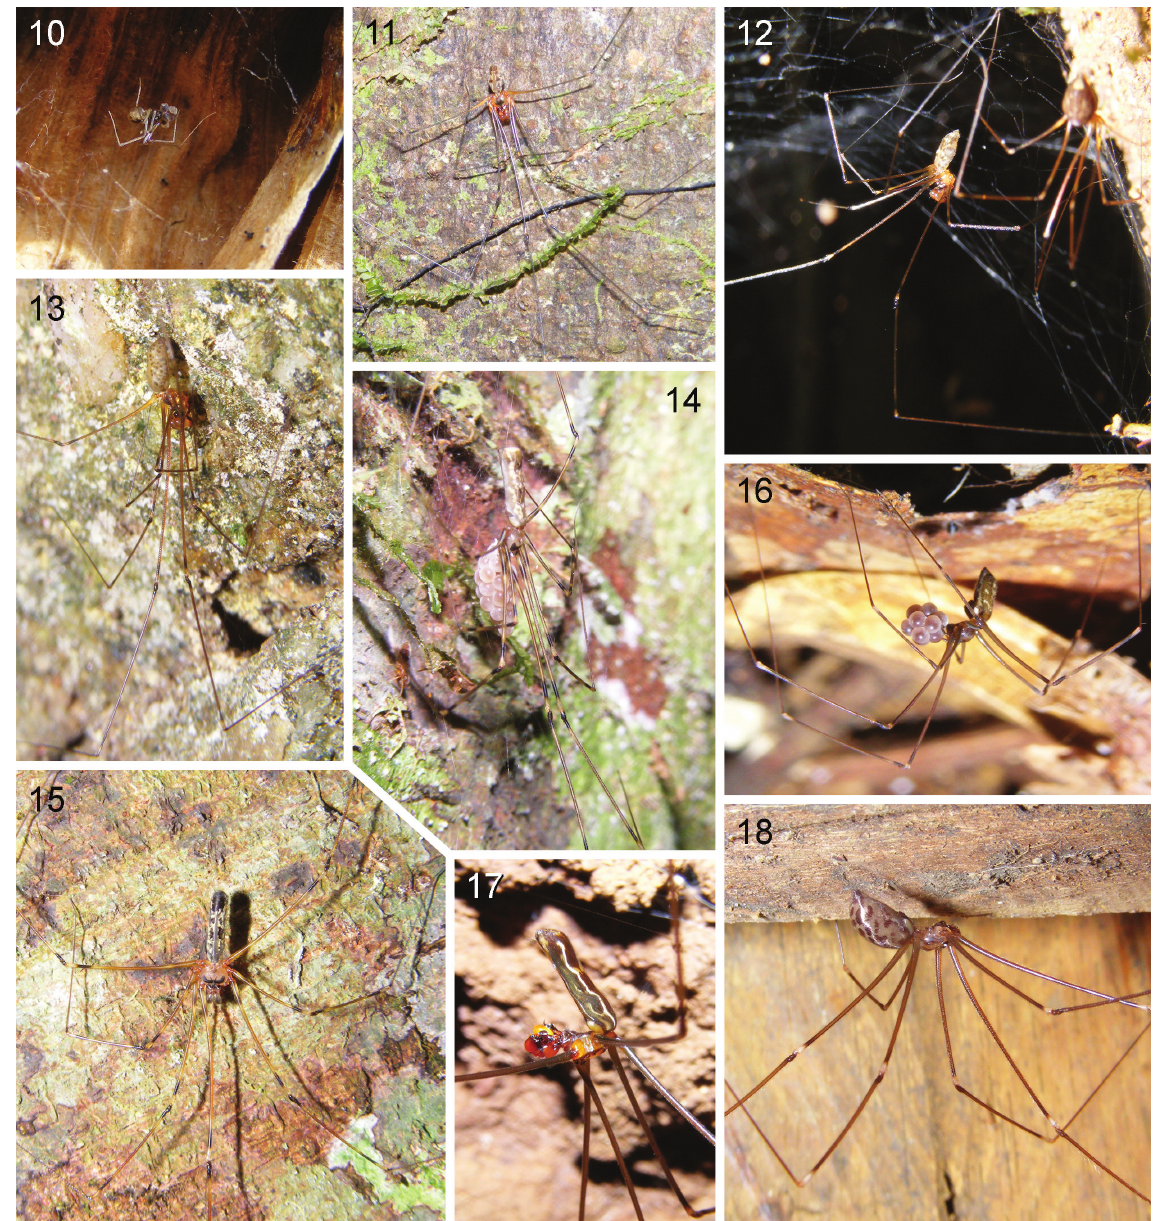
Figs 10-18. Litter, bark and ground-dwelling Central African pholcids. 10 . Anansus kamwai sp. nov., ♀ with eggsac from near Bamenda, Cameroon. 11 . Pholcus moca Huber, 2011, ♂ from near Ndjole, Gabon. 12-13 . Pholcus punu sp. nov., pair from between Mimongo and Yéno (12) and ♂ from Moudouma (13), Gabon. 14-15 . Pholcus rawiriae sp. nov., ♀ with eggsac (14) and ♂ from Mohoba, Gabon (15). 16 . Smeringopina fang Huber, 2013, ♀ with eggsac from Mayebout, Gabon. 17 . Smeringopina belinga Huber, 2013, ♂ from Monts de Belinga, Gabon. 18 . Smeringopus lesserti Kraus, 1957, ♂ from Mayebout, Gabon. Photos